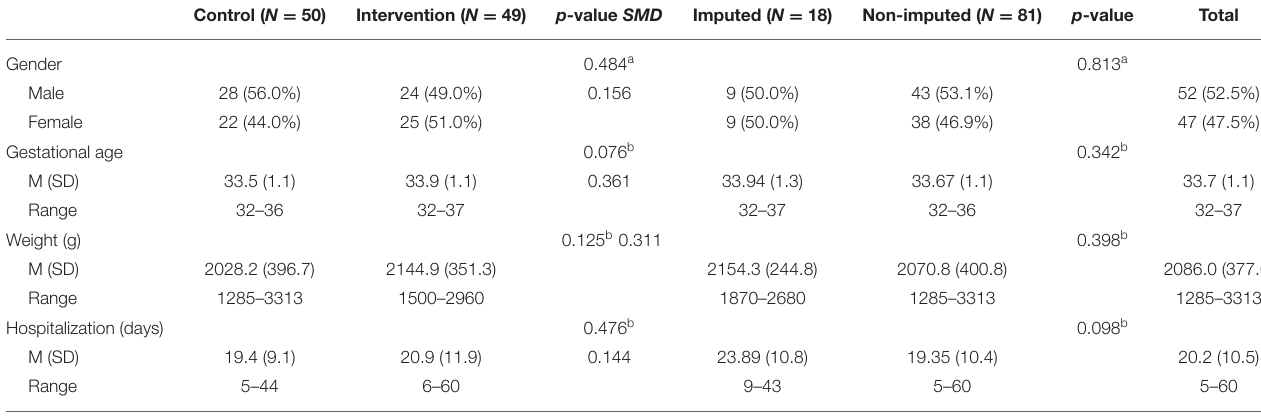
TABLE 2 | Comparisons between conditions and imputed/non-imputed.